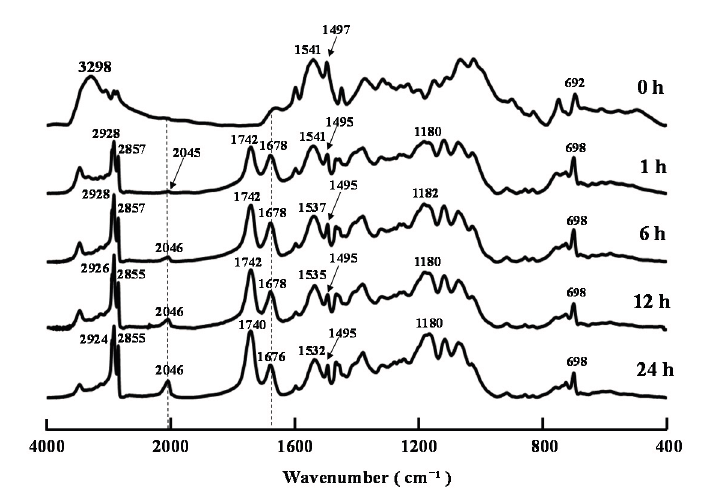
Figure 2. FT-IR spectra of decanoylation products of compound 2 after 0–24